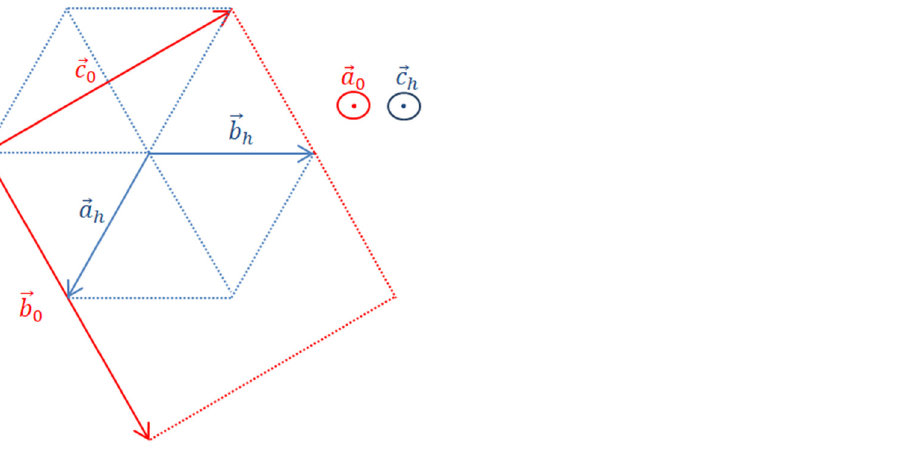
Figure 5. Diagram of correspondence between the two hexagonal and orthorhombic crystal sys- tems.